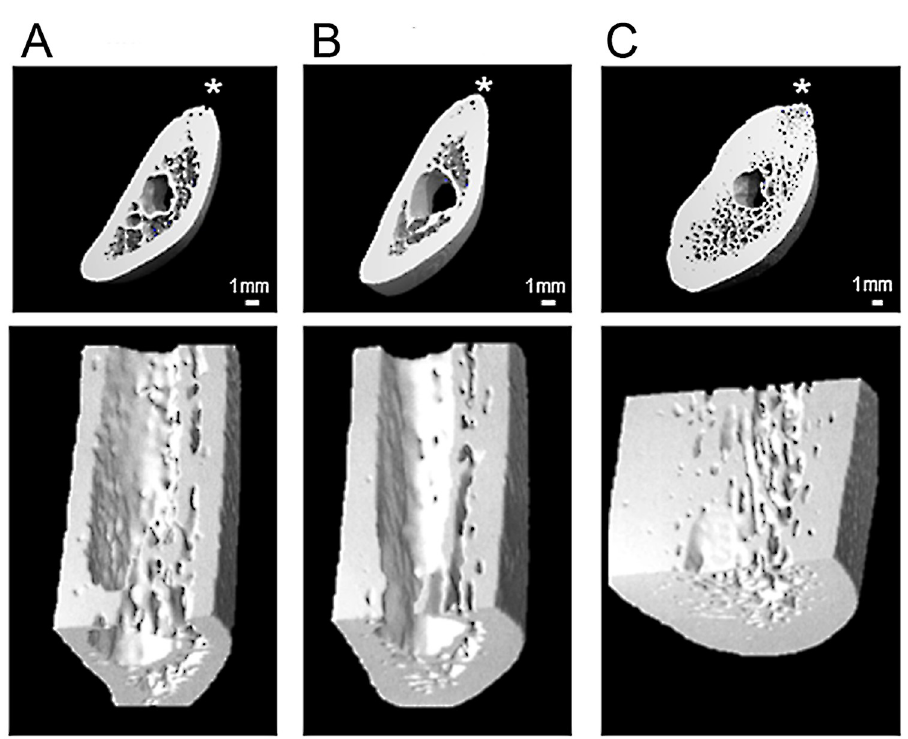
Fig 2. Virtual transverse sections of the retromolar region of the corpus of three left mandibles of harbor seals ( Phoca vitulina ) based on 3D-reconstructions using HR-pQCT data. Upper row: overviews, asterisks indicate dorsal borders of the mandibles; lower row: higher magnification of ventral portion of the mandibular corpus. A: young juvenile; B: yearling; C: adult individual. Note increase in cortical thickness with age.